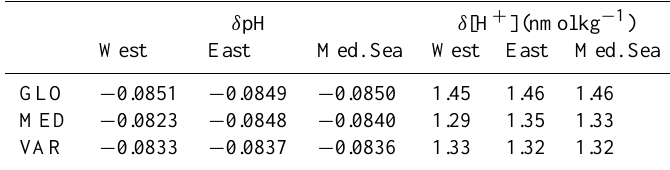
Table 7. Average changes in pH and [H + ] between 1800 and 2001 for the three simulations over western and eastern basins and the entire Mediterranean